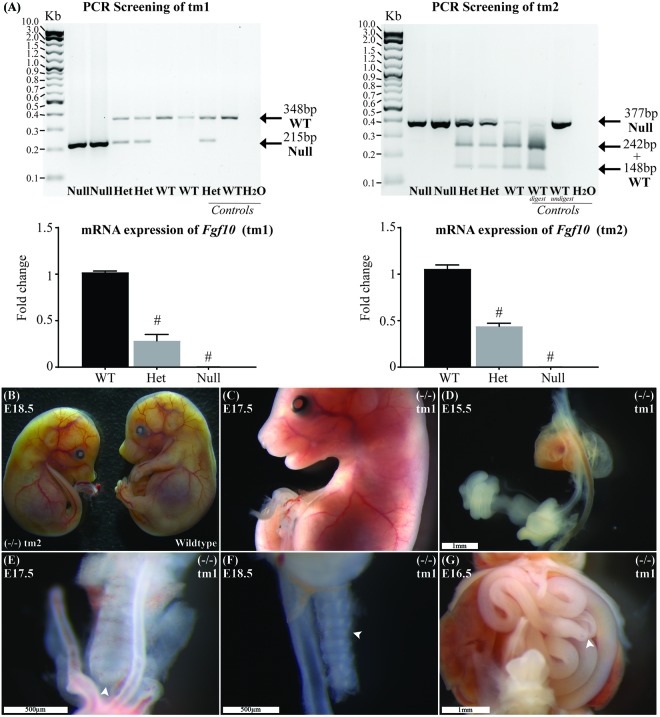
Genotype and general phenotype characterization. (A) Product from standard and RT-qPCR shows genotyping and RNA expression for both tm1 and tm2 strains. (B) General phenotype of a representative Fgf10 null embryo (left embryo) with the expected lack of limbs and smaller than body-size when compared with wild type litter mate (right embryo). Fgf10 null embryos also demonstrated: abnormal facies (C), lung agenesis (D–F), anomalous tracheal rings (F), and caecal atresia (G). Arrows highlight features of interest. Gestational ages for panels B–G are as stated. #p-value < 0.001, comparing either Fgf10 heterozygous or null mice to their wild-type littermates using Student’s t-test.